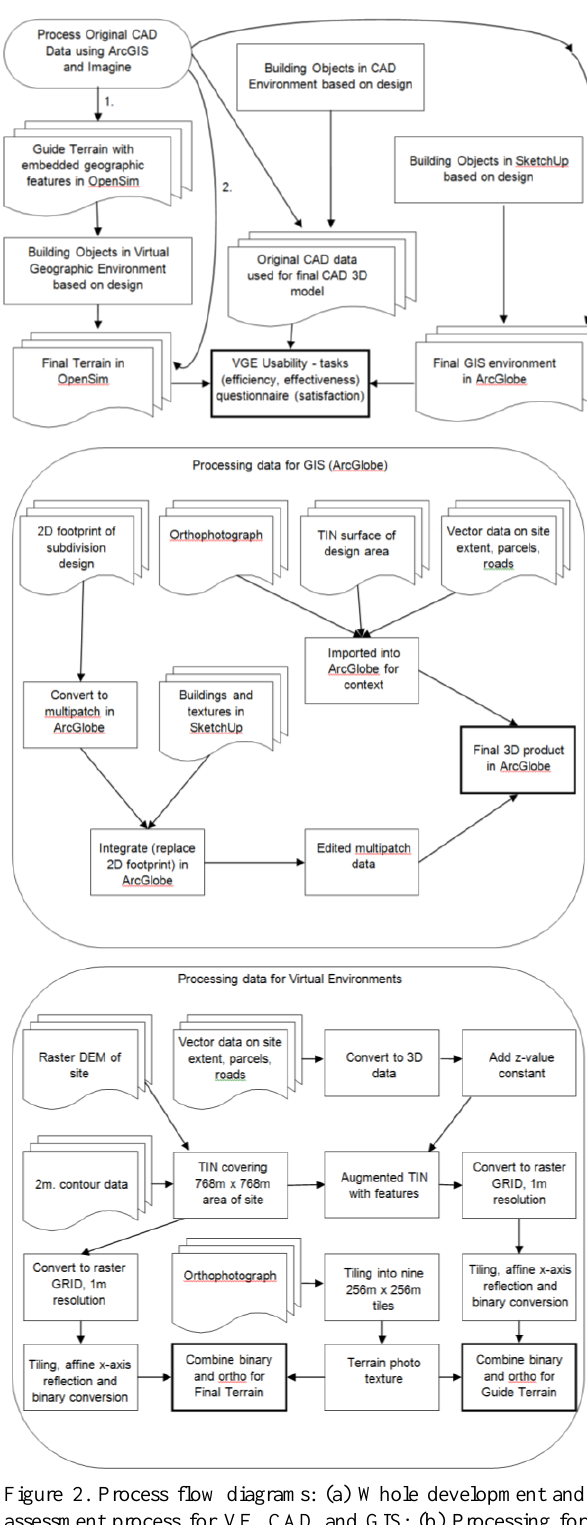
Figure 4. The GIS 3D environment in ArcGlobe – the green polygon is reserve area.Inset: Modern 2-floor house